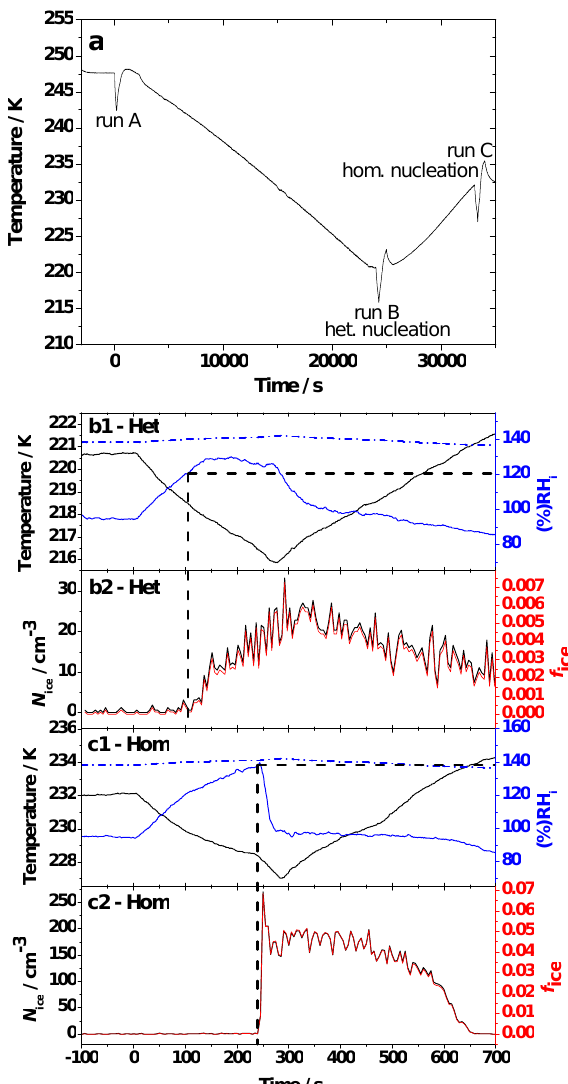
Fig. 6. A comparison of the behaviour of aqueous HMMA solution in expansion runs B and C. Panel (a) shows the temperature profile of the experimental series. The bottom panels show experimental data for runs B (started at 220.7K) and C (started at 232.1K). Pan- els (b1) and (c1) show in each case the experimental temperature and humidity (black and blue solid lines respectively). Panels (b2) and (c2) show the ice particle number concentration ( N ice , black line) and the fraction of the aerosol frozen ( f ice , red line). The ex- pected humidity of homogeneous ice nucleation based on liquid sul- phuric acid aerosol freezing data (M¨ohler et al., 2003) is indicated in panels B1 and C1 by dash-dot blue lines. The time/RH i onsets of ice nucleation are marked with dashed black lines. In each case the onset was observed as an increase of at least 1% in the backscatter- ing linear depolarisation ratio, which is the most sensitive indicator for the presence of ice particles. This allows the detection of ice particles before they have grown large enough to be counted by the WELAS